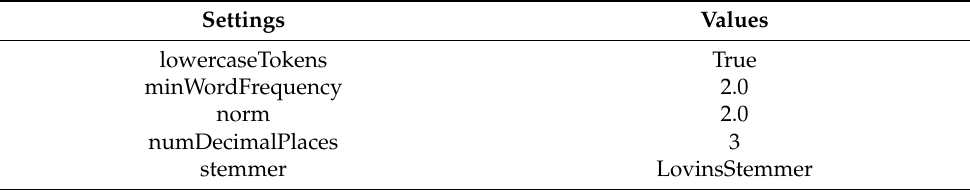
Table 1. The settings of the Naïve Bayes Multinomial Text model training.